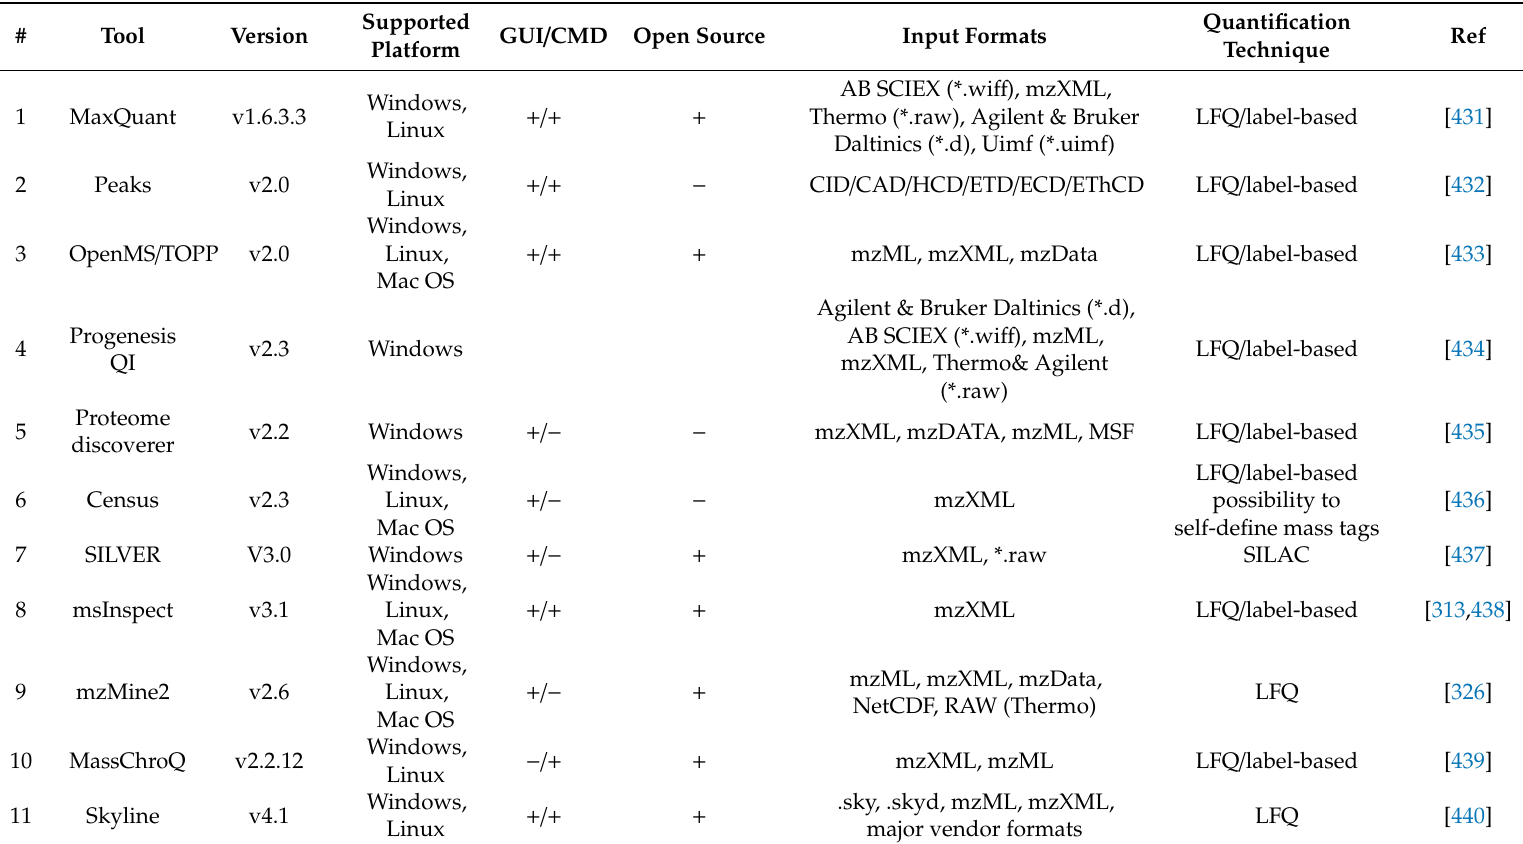
Table A3. Software tools for processing and post-processing for proteomics